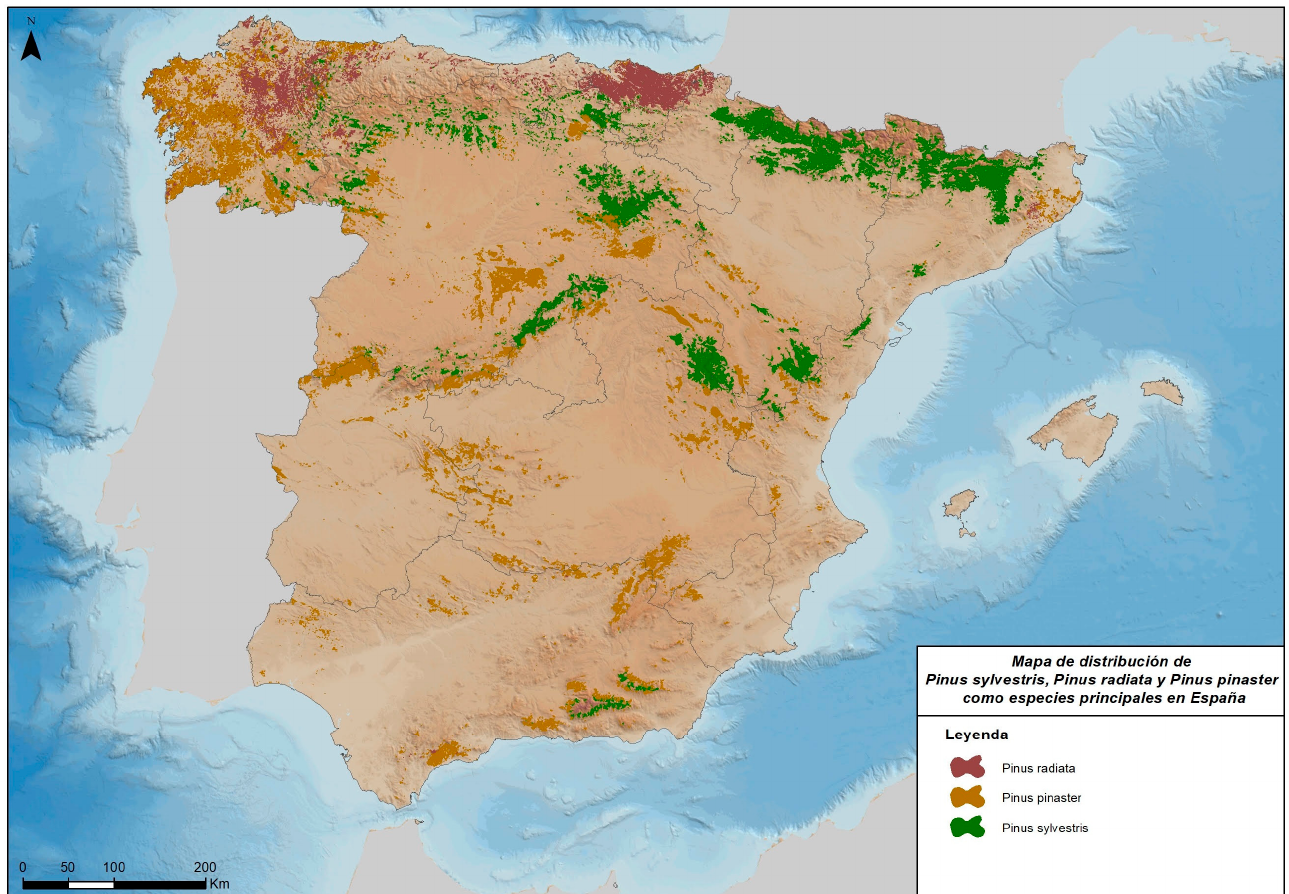
Figure 2. Distribution of maritime, radiata, and Scots pine in Spain [17].